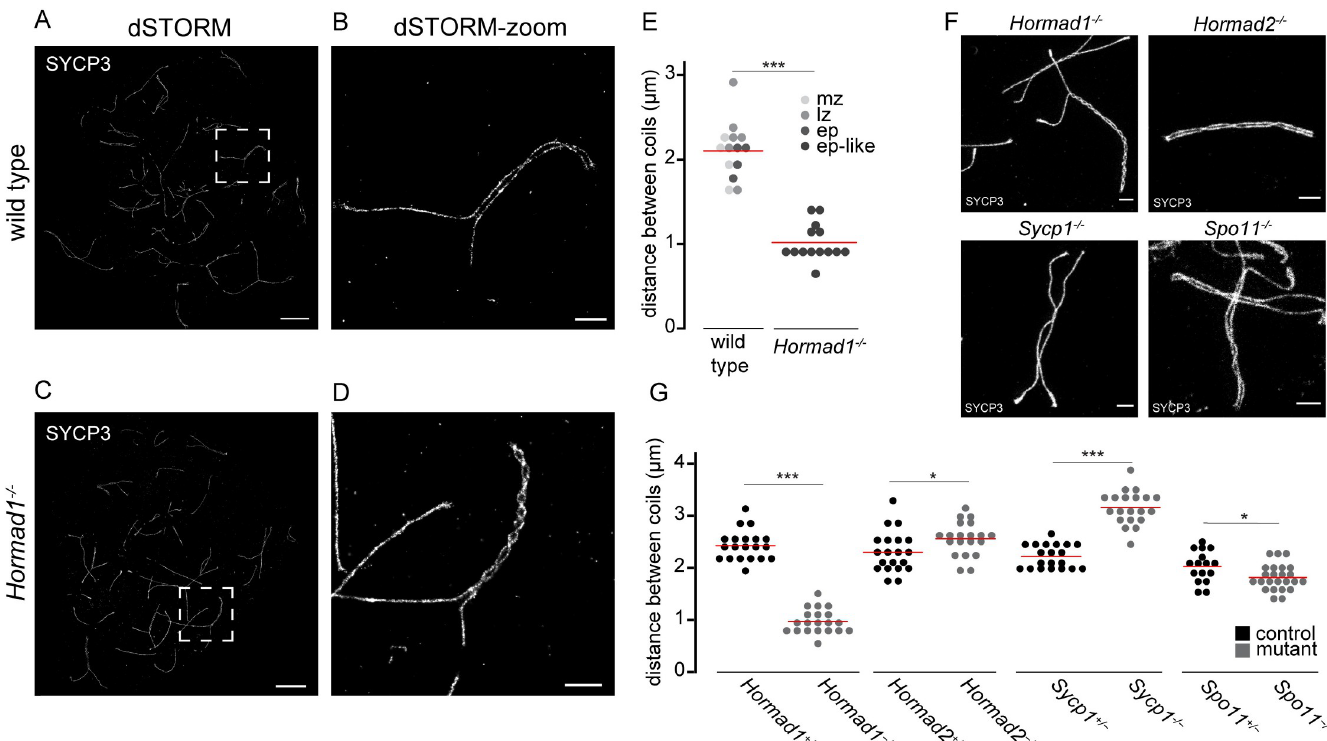
Fig 9. Synaptonemal complex coiling on meiotic spread spermatocytes of several mutants investigated with dSTORM and STED microscopy. A) dSTORM image of wild type mid-zygotene nucleus immunostained for SYCP3. B) Close-up of boxed region shown in A. C) dSTORM image of Hormad1 -/- early pachytene-like nucleus immunostained for SYCP3. D) Close-up of boxed region shown in C. E) Dotplot of distance between coils of SYCP3 of wild type and Hormad1 -/- in mid zygotene-early pachytene nuclei of wild type and early pachytene-like nuclei of Hormad1 -/- . Color code represents the different meiotic stages. Mid zygotene (mz), late zygotene (lz), early pachytene (ep), early pachytene-like (ep-like). F) Representative STED images of meiotic spreads of Hormad1 -/- , Hormad2 -/- , Sycp1 -/- and Spo11 -/- late prophase nuclei immunostained for SYCP3. G) Dotplot of distance between coils for the mutants showed in F whereby each dot represents an average per nuclei. In both E and G, the red line indicates the mean. Scale bars in A,C and B,D,F represent 5 μ m and 1 μ m respectively. p-values can be found in S2 Table.